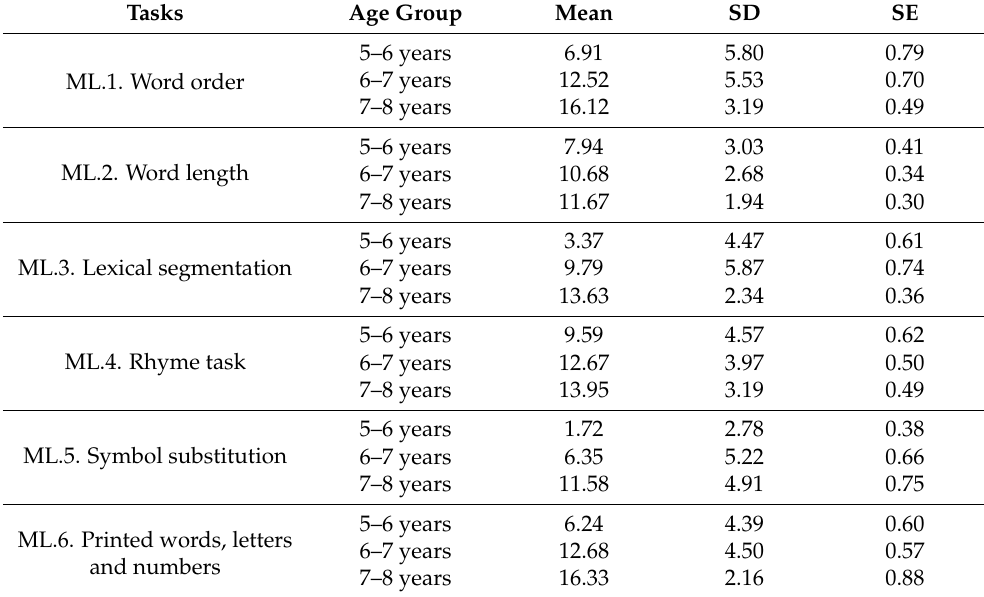
Table 2. Descriptive statistics for metalinguistic tasks by age